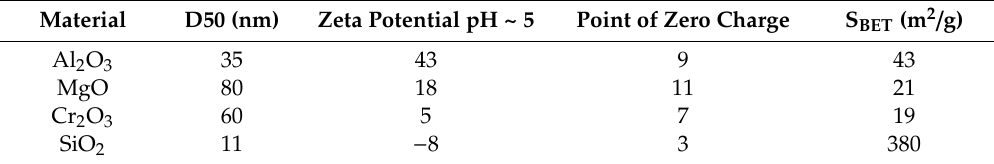
Table 1. Mean particle size (D50), zeta potential, point of zero charges and,